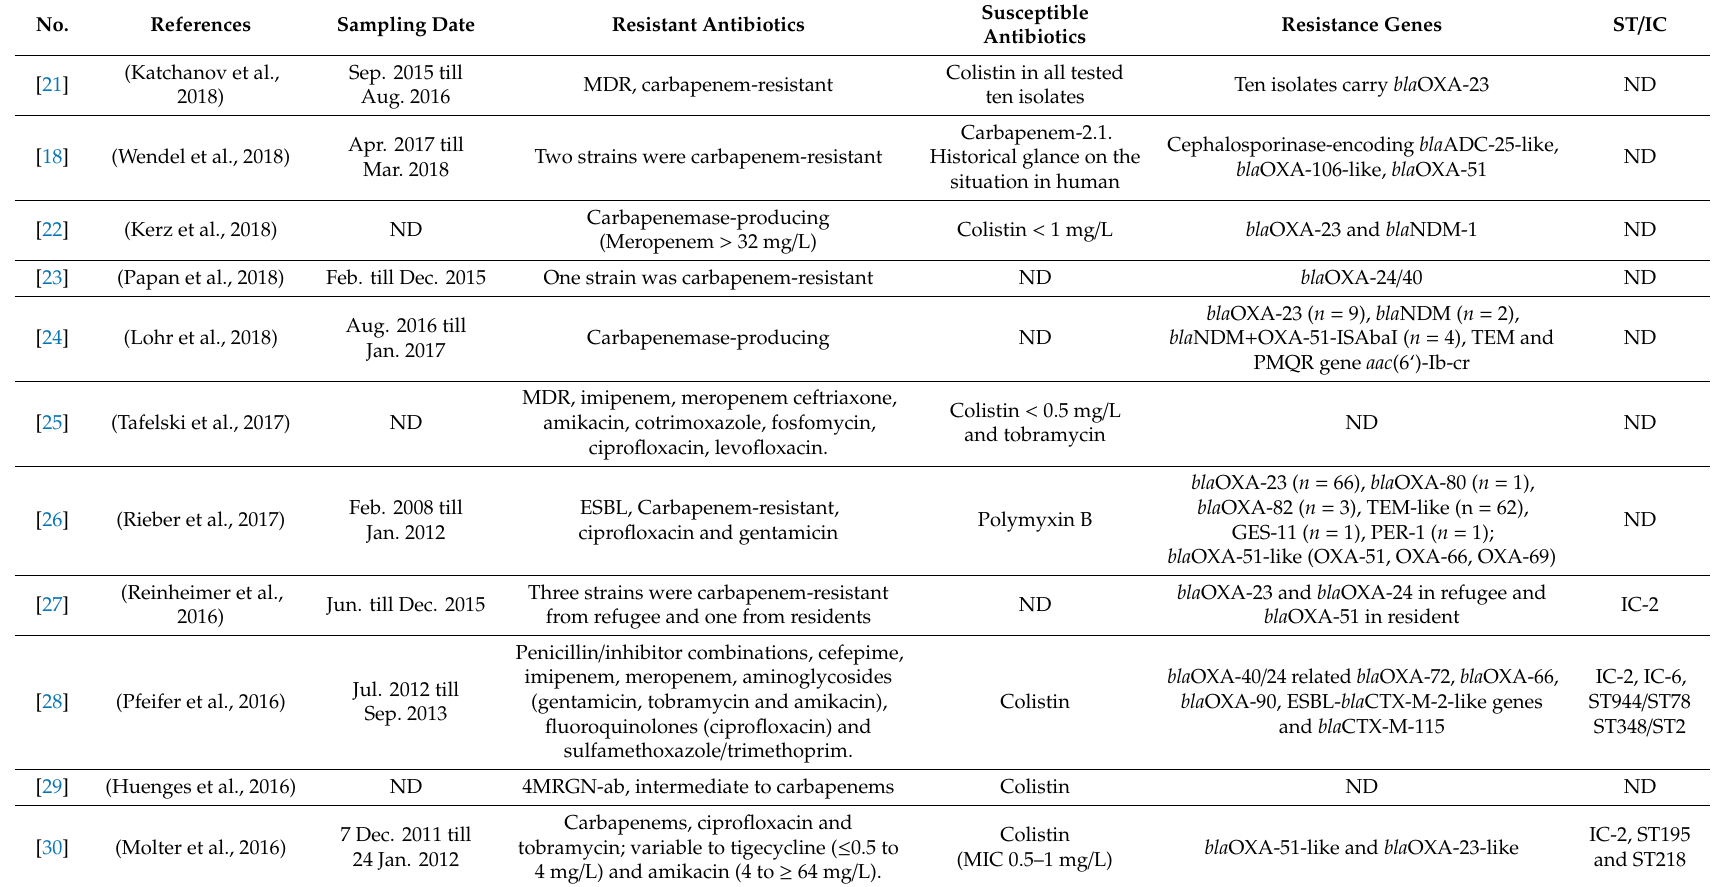
Table 3. Temporal distribution of resistance profiles of A. baumannii strains from Germany based on studies published from 2000 to 2018.